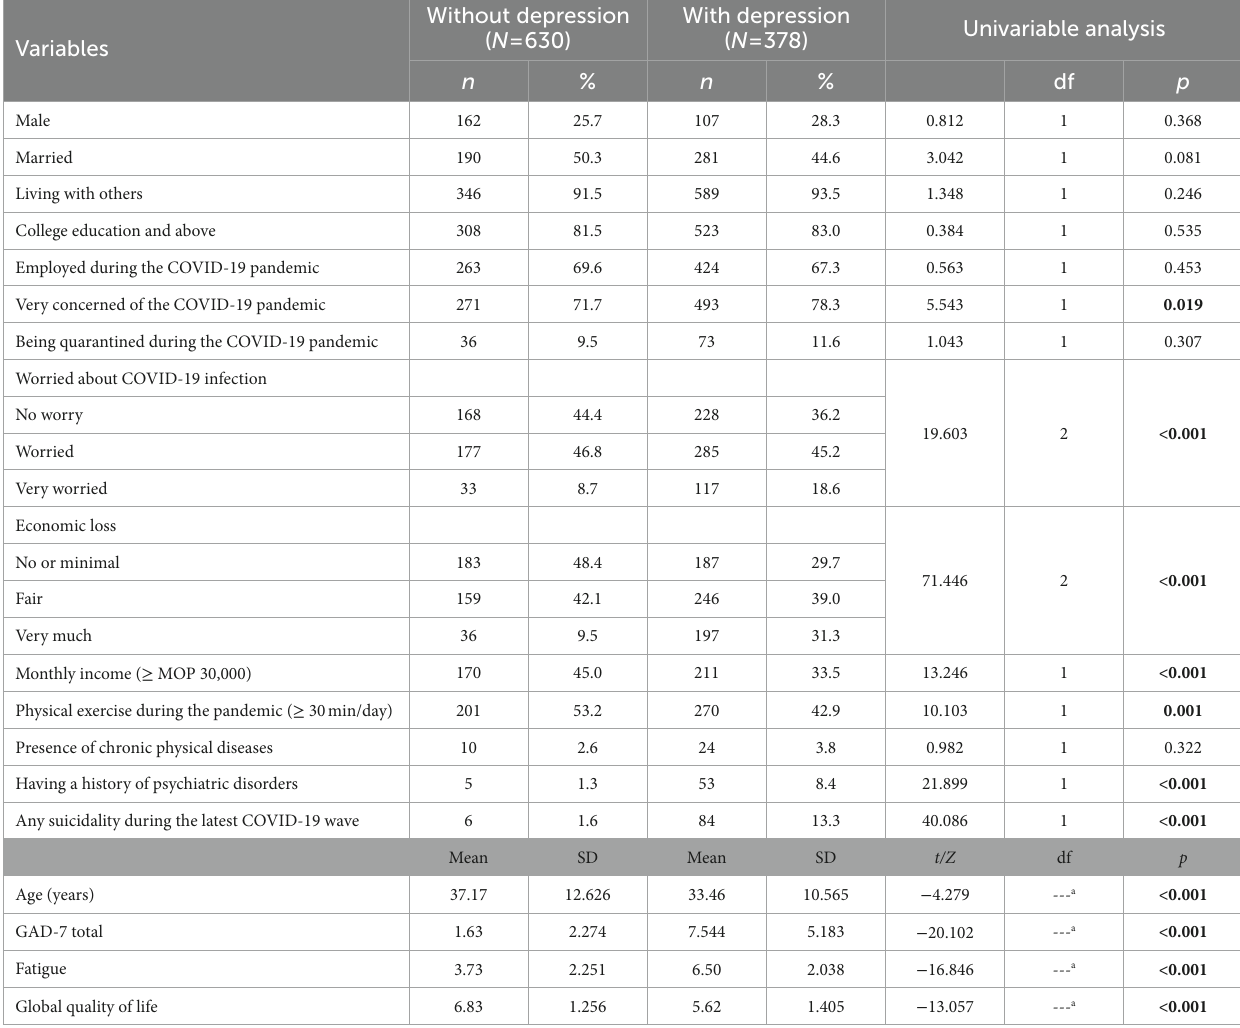
TABLE 1 Comparison between Macau residents with and without depressive symptoms with respect to demographic and clinical